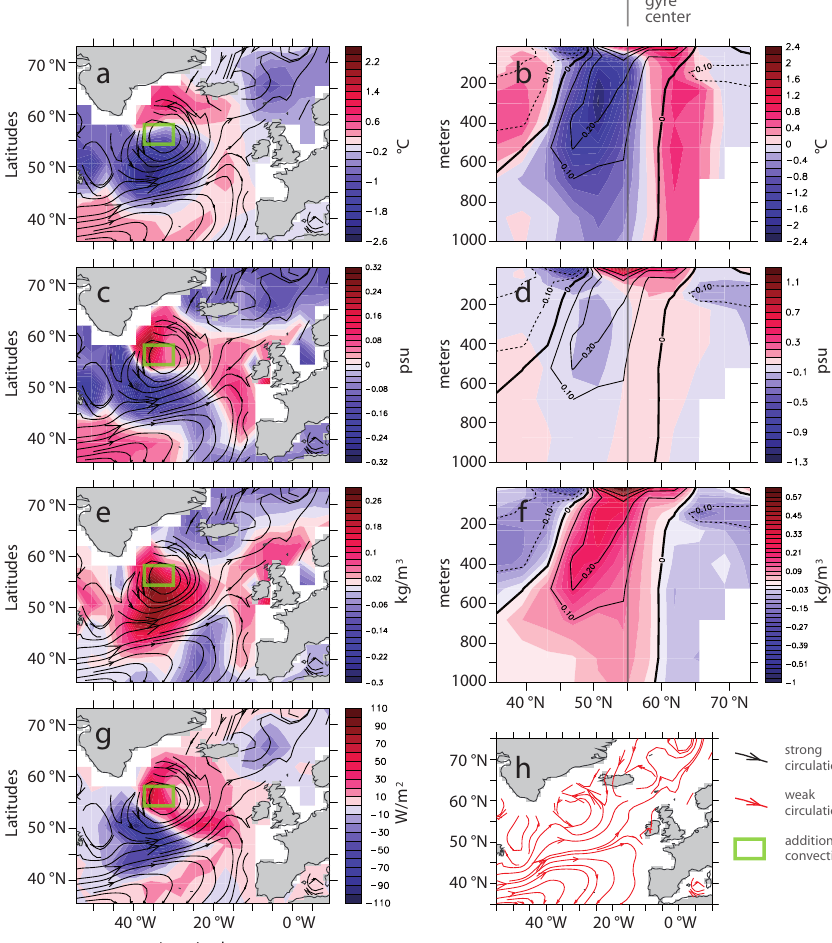
Fig. 2. Difference between the strong (15mSv forcing) and weak (control) SPG circulation. Panels (a, b) show temperature, (c, d) salinity, (e, f) density and (g) heatflux. Panels (a, c, e) show averages over the upper 1000m, black flowlines in panels (a, c, e, g) show upper 1000m strong state velocities. Panel (h) shows weak upper 1000m velocities as flowlines in red. Panels (b, d, f) show zonal averages between 37.5 ◦ and 18.75 ◦ W with density anomalies as contours and the approximate gyre centre as a grey